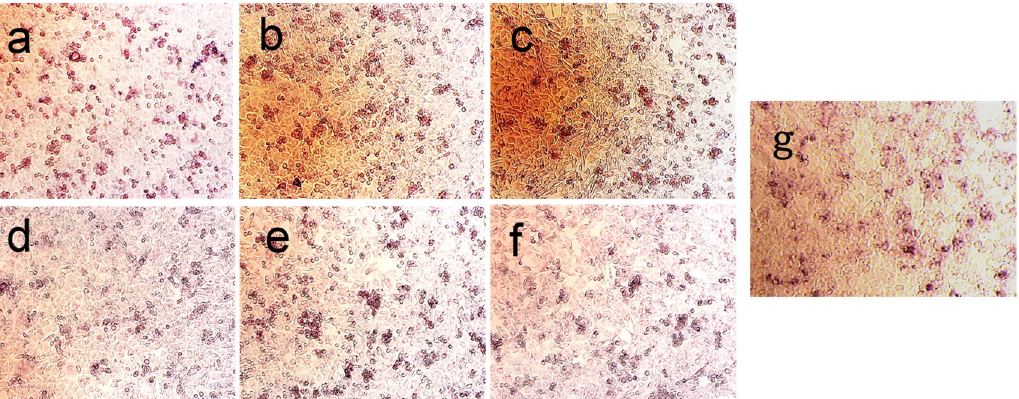
Figure 7. ALP activity images of MG-63 cells co-cultured with HA samples: ( a ) CS1000-1; ( b ) CS3000-1; ( c ) CS5000-1; ( d ) CS1000-2; ( e ) CS3000-2; ( f ) CS5000-2; ( g ) Control.